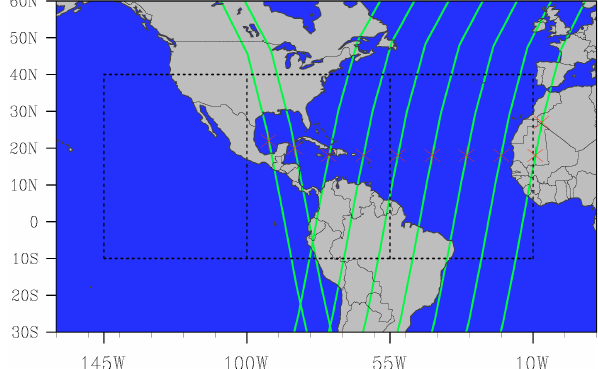
Fig. 3. Map used in this study for Saharan dust. The dashed lines denote the four longitude planes (10 ◦ W, 55 ◦ W, 100 ◦ W, and 145 ◦ W) and the latitude boundary (10 ◦ S to 40 ◦ N). The CALIPSO tracks are shown as lines along the